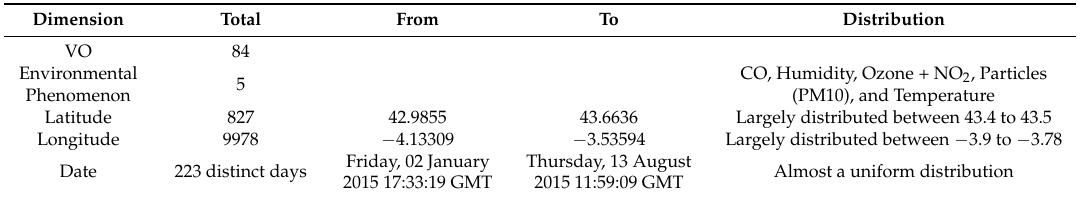
Table 5. Statistics of the collected SmartSantander